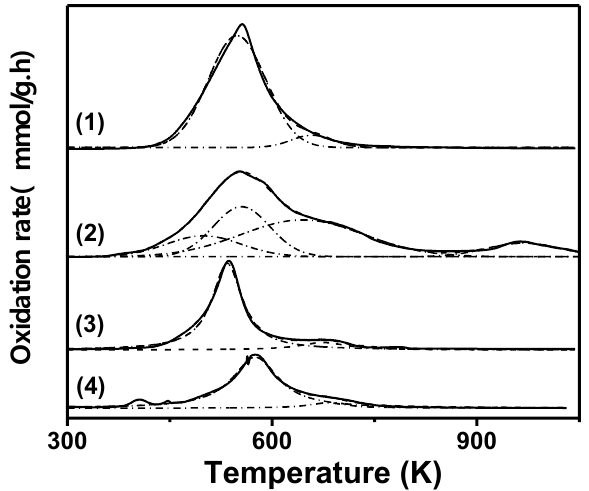
Figure 7. Temperature-programed oxidation profiles of the used Cu-based catalyst. (1) Cu/Al 2 O 3 -I, (2) CuMgAl, (3) Cu/SiO 2 -PD (4) Cu/SiO 2 -I (O 2 (5%)/N 2 ; 60 mL/min −1 ; 10 K/min −1 ).